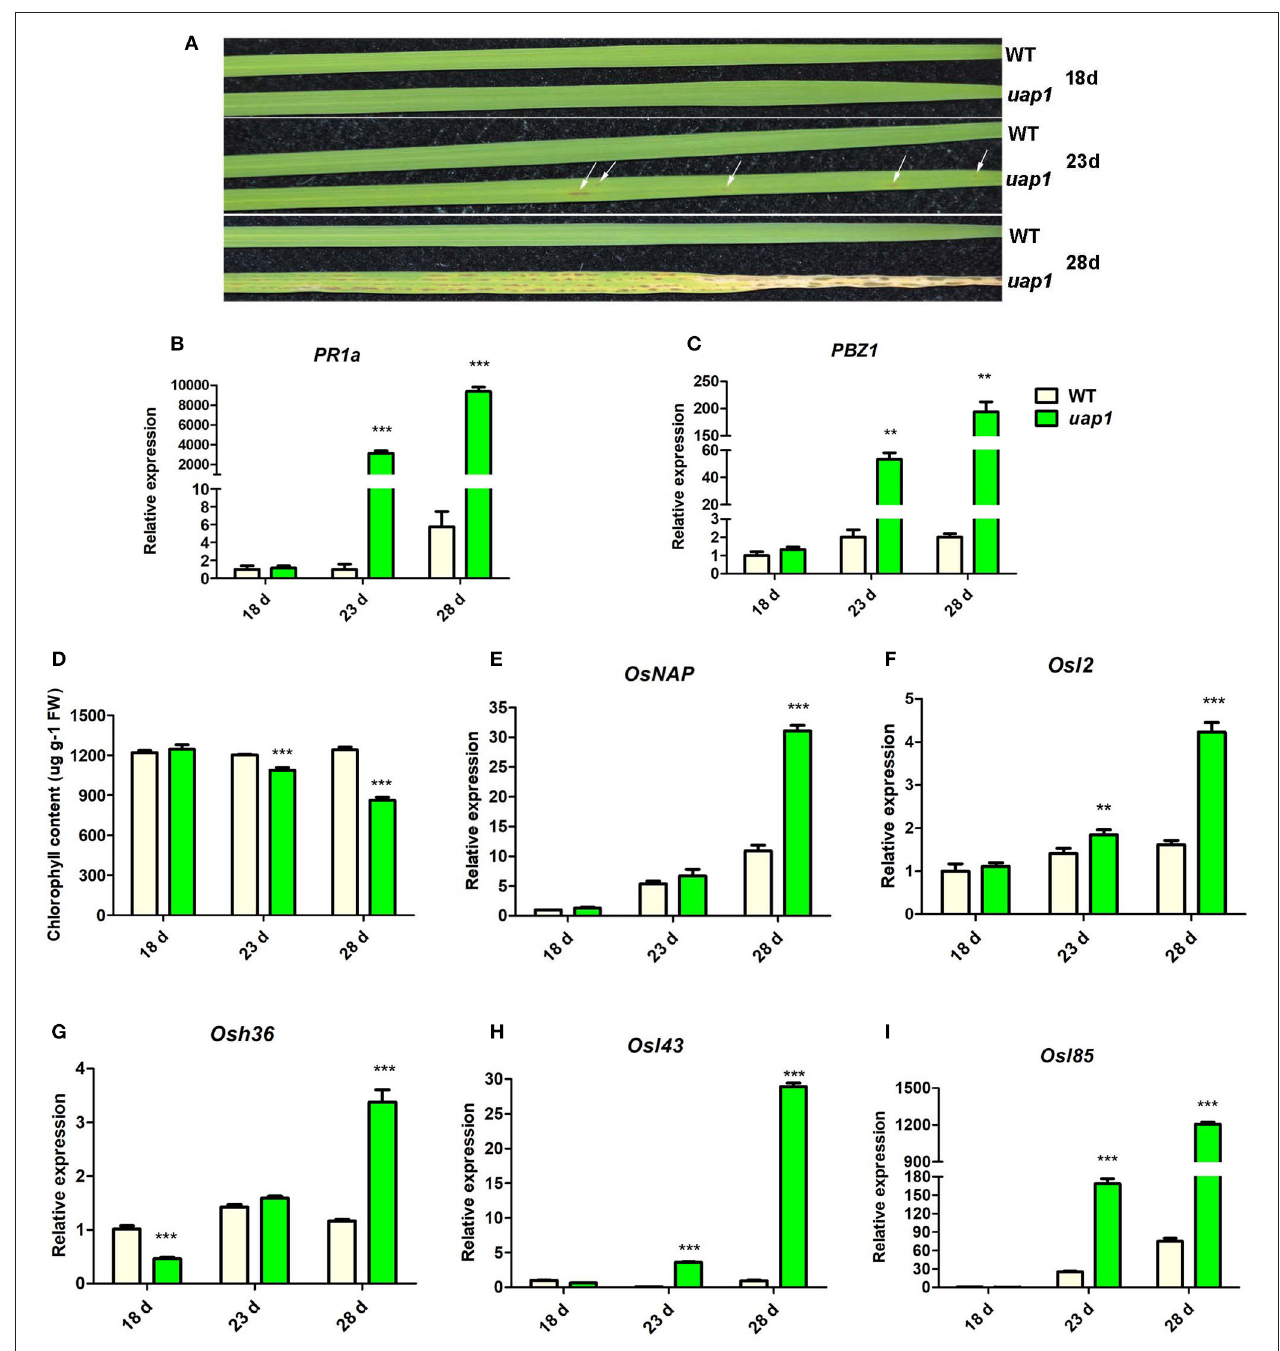
FIGURE 1 | Characteristics of phenotype and molecular markers of wild-type and uap1 mutant leaves. (A) Leaf phenotype of plants at the seedling stage (18, 23, and 28 days after germination). The white arrows indicate the leaf spots. (B,C) Relative expression of two defense signaling-related genes PR1a and PBZ1 . (D) Chlorophyll contents. FW, fresh weight. (E) Relative expression of senescence-associated transcriptional factor OsNAP . (F–I) Relative expression of four senescence-associated genes (SAGs) Osl2 , Osh36 , Osl43, and Osl85 . Relative expression of genes by qRT-PCR is normalized with reference genes UBC , Profilin-2, and Actin1 . All